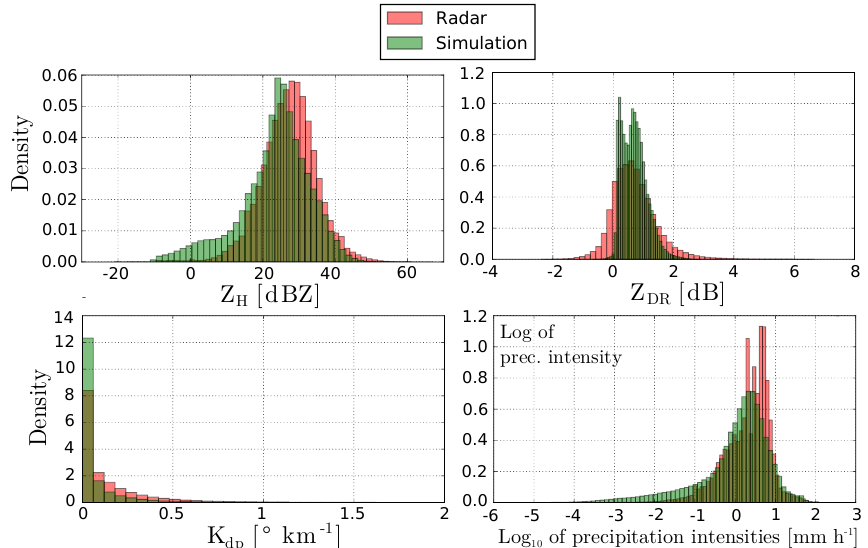
Figure 17. Observed (red) and simulated (green) distributions of polarimetric variables ( Z H ,Z DR and K dp ) as well as the precipitation intensities on the ground (in log scale) for the one-moment scheme with µ rain = 2 in the liquid